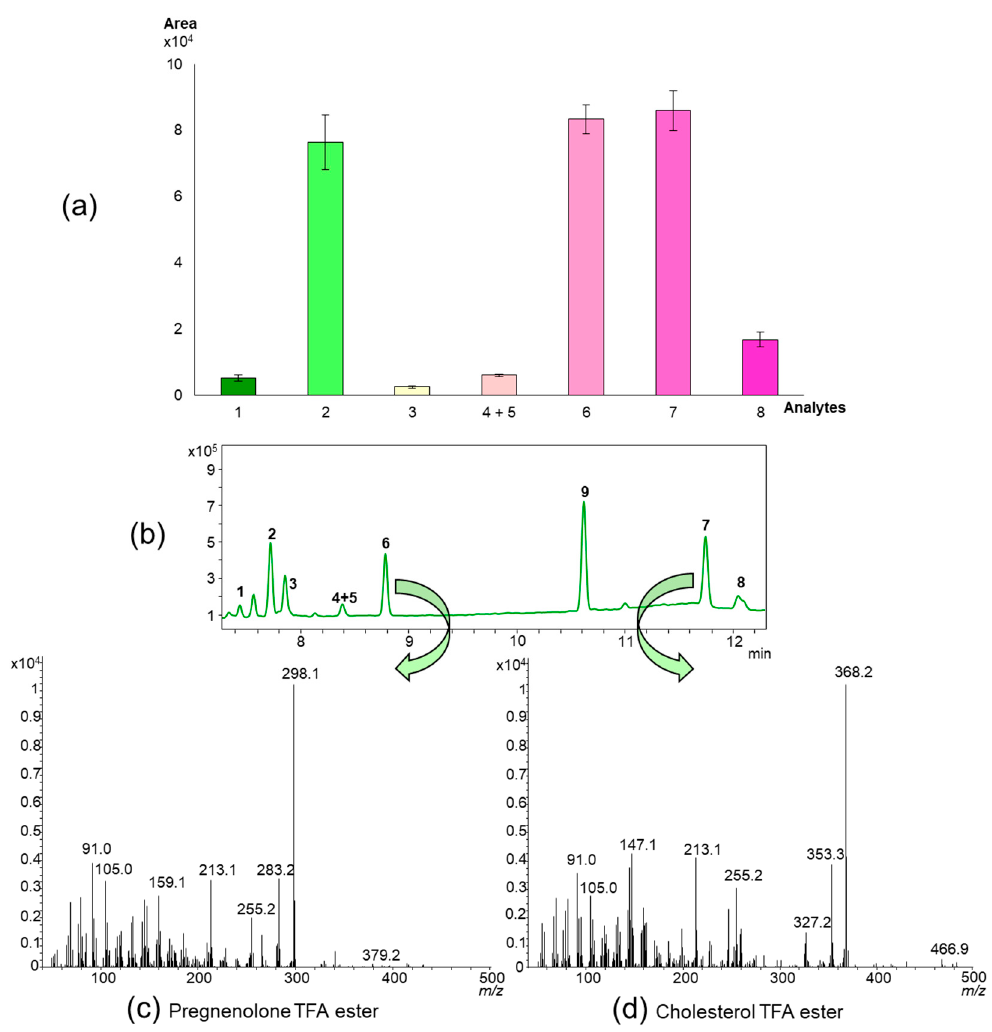
Figure 5. ( a ) Bar chart with mean base peak areas and standard deviations (n = 6) of the sterol TFA esters obtained by treatment of sterol sulfates 1 – 8 with trifluoroacetic anhydride. ( b ) Total ion chromatogram (TIC) of the eight sterol TFA esters and the internal standard, derived from: 1 androsterone sulfate, 2 dehydroepiandrosterone sulfate, 3 epiandrosterone sulfate, 4 allopregnanolone sulfate, 5 pregnanolone sulfate, 6 pregnenolone sulfate, 7 cholesterol sulfate, 8 25-hydroxycholesterol sulfate, and 9 cholestane (IS). ( c ) Mass spectrum of pregnenolone TFA ester ([M] + m / z 412). ( d ) Mass spectrum of cholesterol TFA ester ([M] + m / z 482). For chromatographic and mass spectral characteristics see Supplementary Table S1.